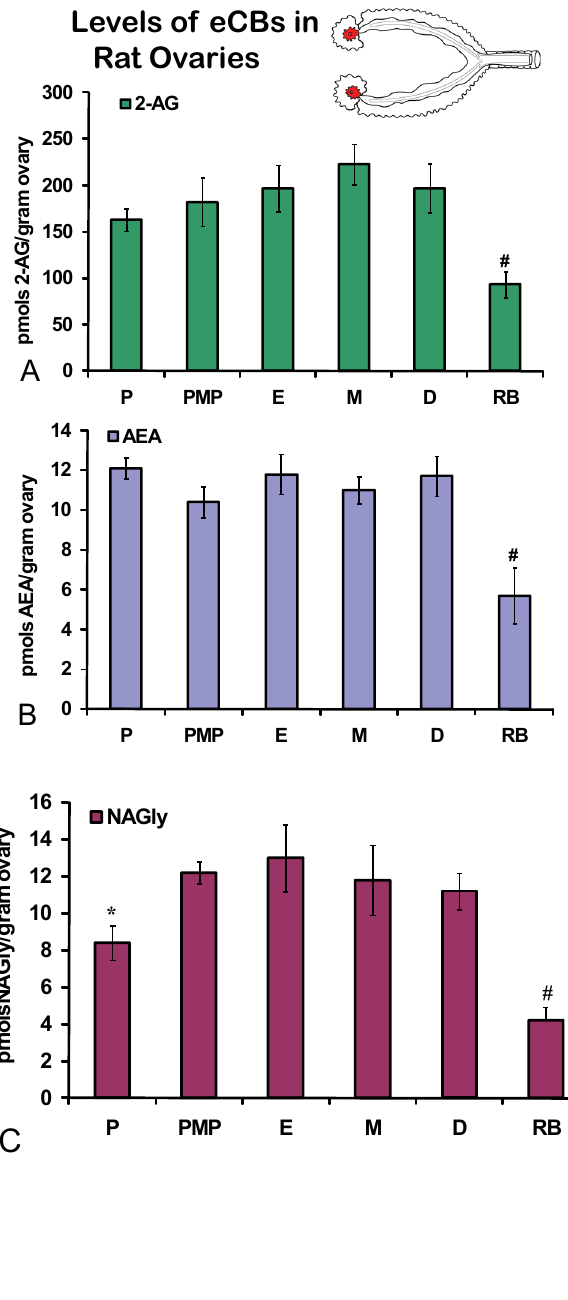
Figure 2. Levels of eCBs in rat ovaries across the hormonal cycle and in anovulatory retired breeders . P = proestrus AM; PMP = proestrus PM; E = estrus; M = metestrus, D = diestrus; RB = anovulatory retired breeders. * p ≤ 0.05 and represents comparisons across the hormonal cycle. # p ≤ 0.05 and represents comparisons of hormonal cycle groups with retired breeders. Levels of eCBs in Rat